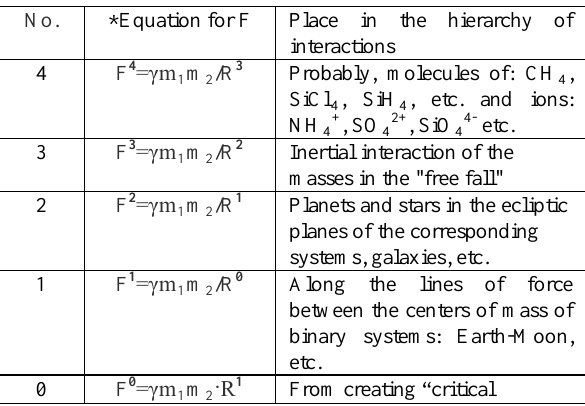
Table 1. Estimated gravity (F) in worlds with metrics (No.) from 4 to